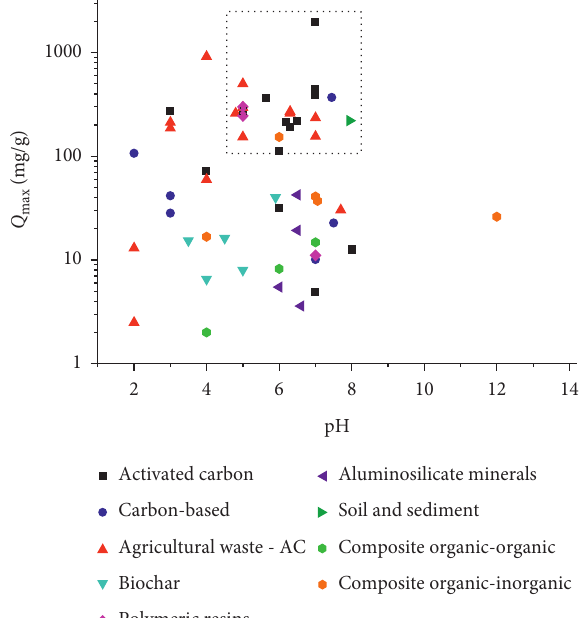
Figure 7: Relationship between the maximum adsorption capacity by adsorbent subgroups and